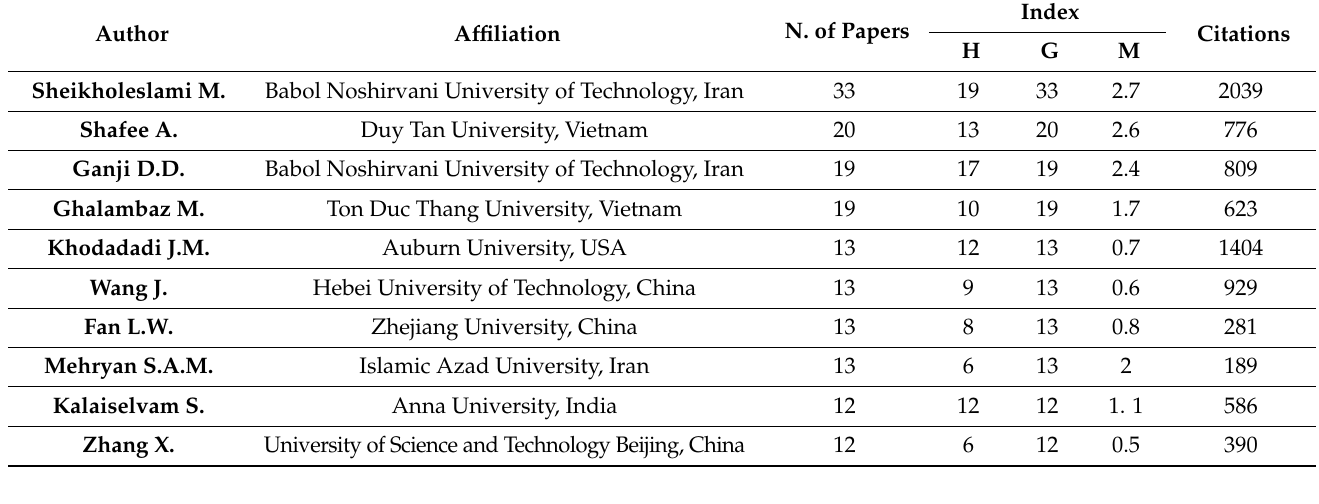
Table 2. Top 10 authors in the NePCM field.